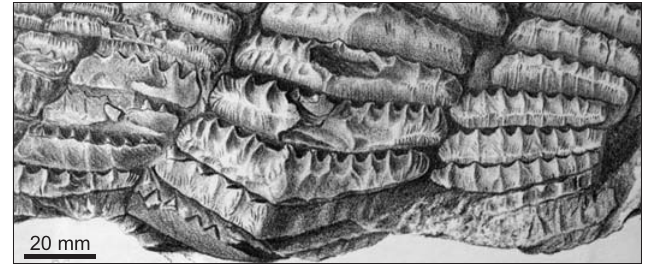
Fig. 9. Fragment of the mandibular dentition of “ Agassizodus variabilis ” from the Coal Measures (Pennsylvanian) of Osage County, Kansas, USA; from St. John and Worthen (1875: pl. 8: